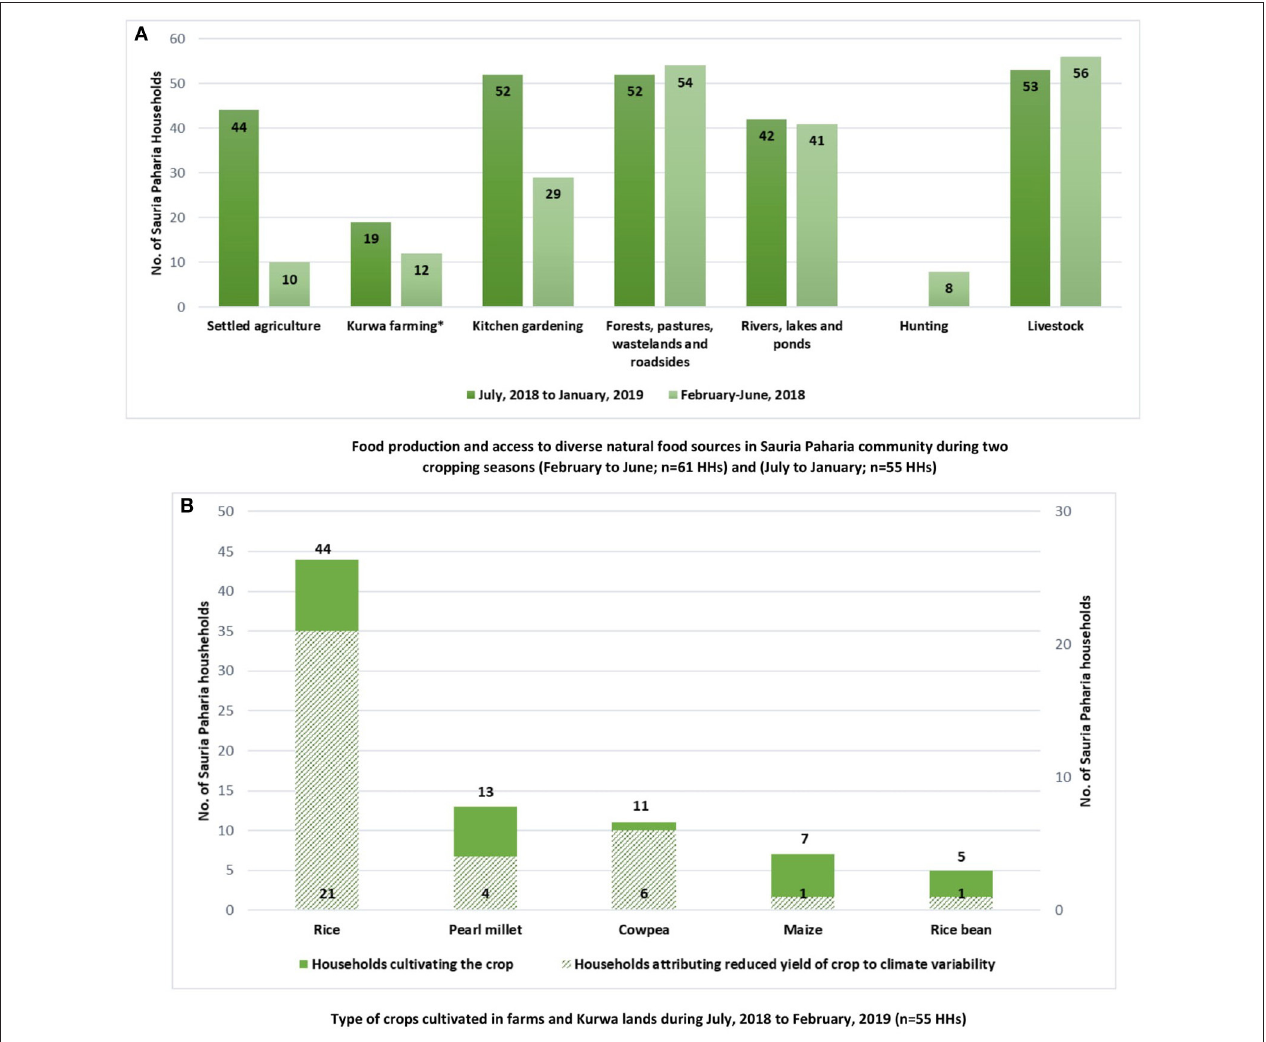
FIGURE 5 | (A,B) Agroforestry production and diversity in Sauria Paharia community, Jharkhand, India. *Kurwa farming refers to utilization of small patches of forest lands for slash and burn cultivation.